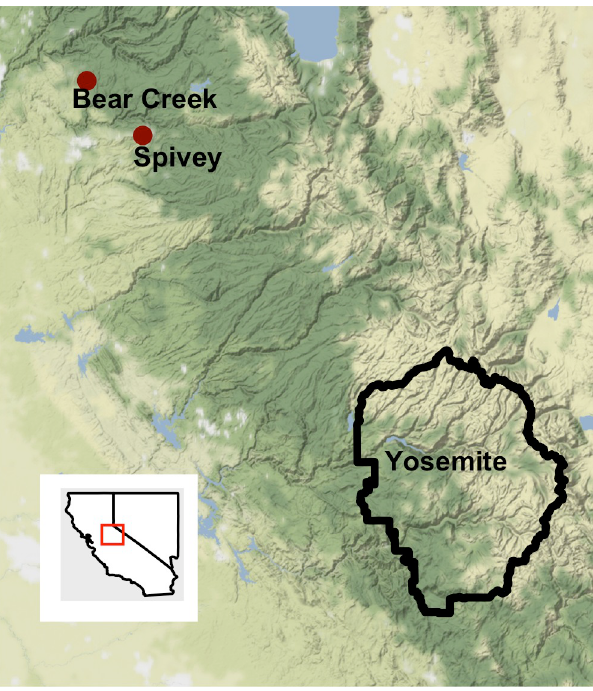
Fig 1. Map of the study area. The map was generated in R [67] using the “ggmap” [78] and “ggplot2” [79] packages with map tiles by Stamen Design (www.stamen.com) and data by OpenStreetMap, under ODbL, under CC BY